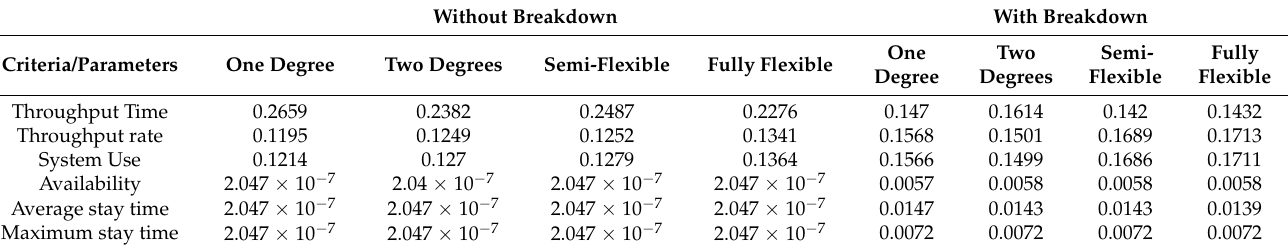
Table 13. Weighted normalized decision matrix.